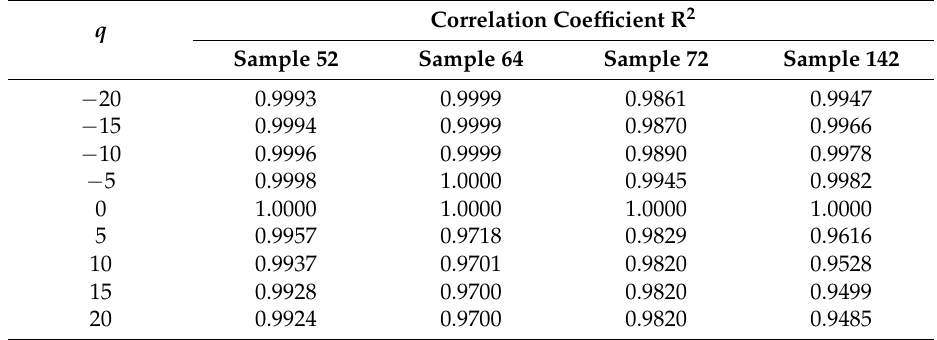
Table 3. Coefficients for correlation determination R 2 of the fitting lines between log( ε ) and log( χ ( ε )).